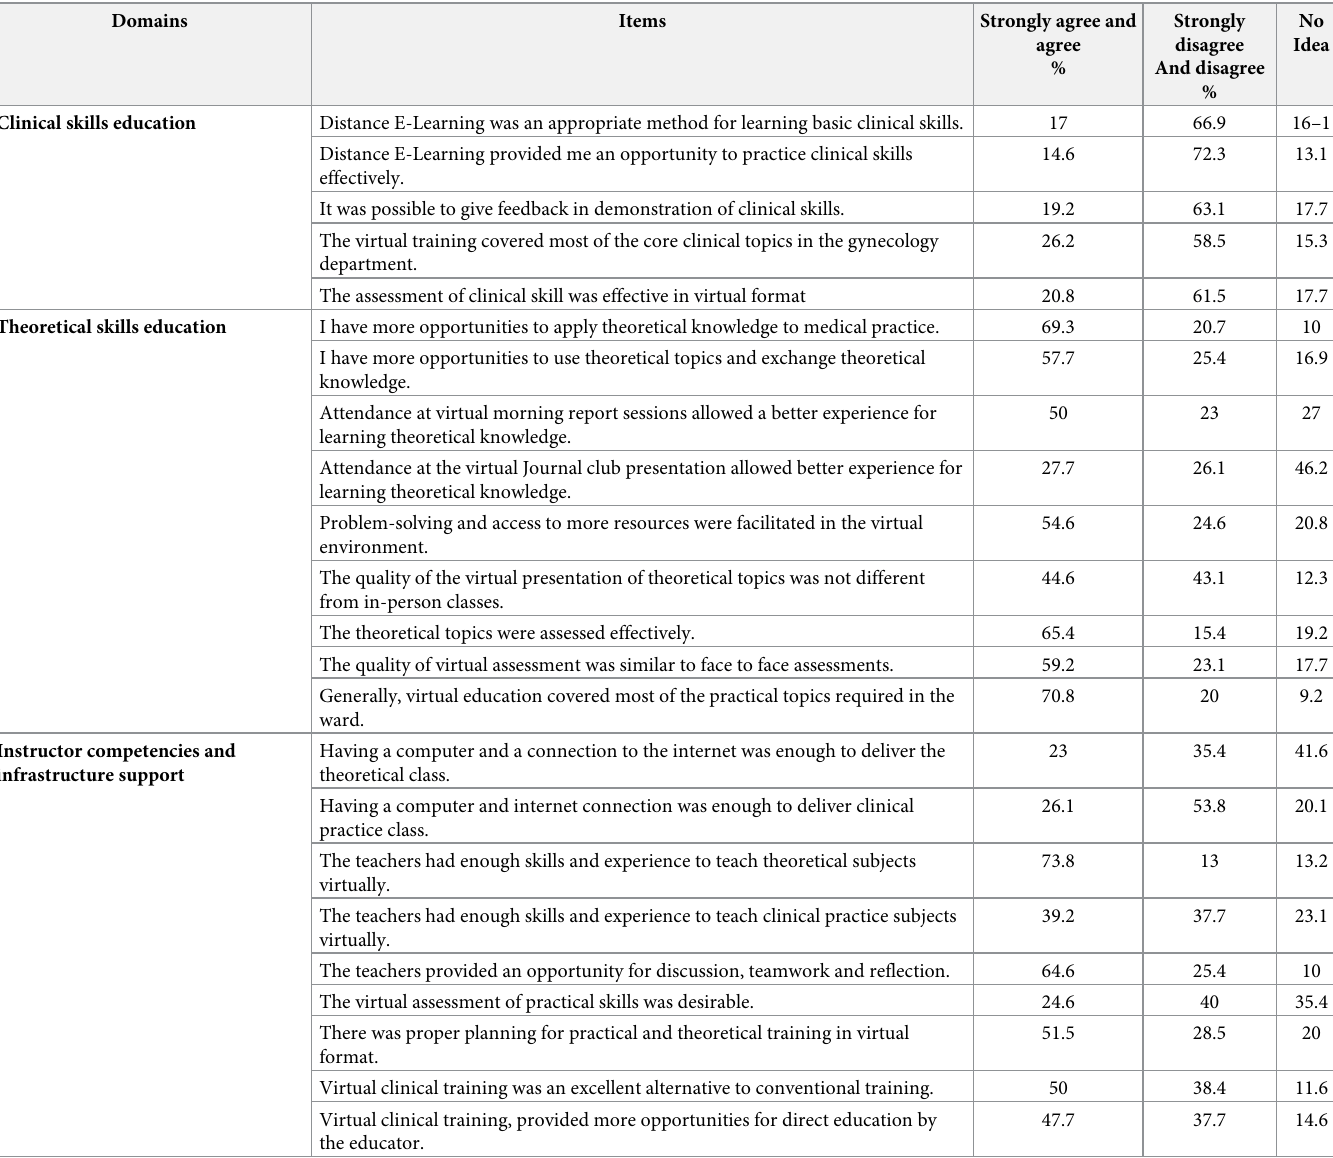
Table 2. Frequency distribution of 130 respondents regarding to medical students’ perceptions towards DEL in gynecology ward during the Covid-19 pandemic.